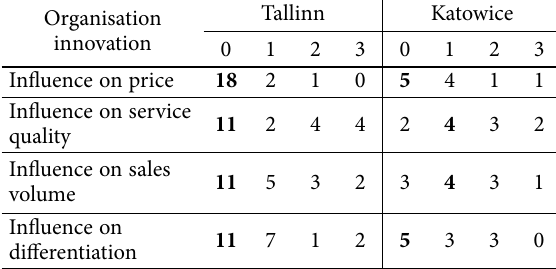
Table 6. Management innovation influences in the air cargo